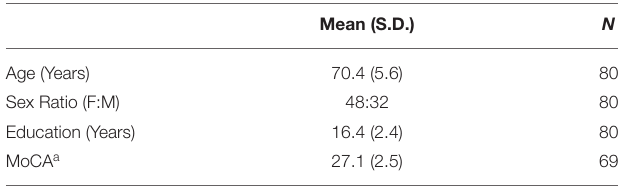
TABLE 1 | Group demographics and Montreal Cognitive Assessment (MoCA a )